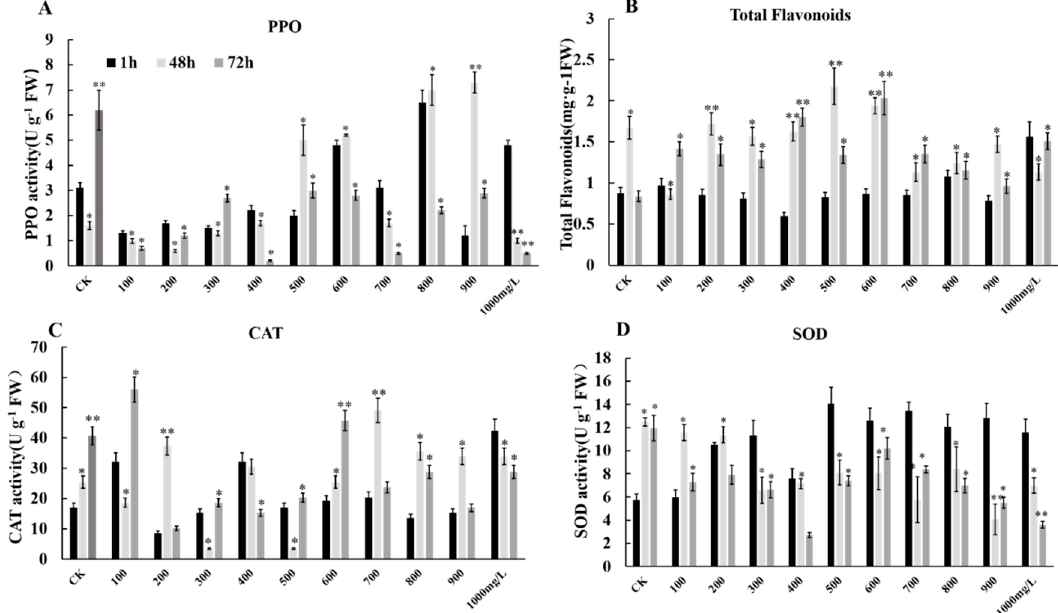
Figure 10. Effects of different concentrations of ethephon treatment on the total flavonoids and antioxidant enzymes. Different concentration of ethephon (100, 200, 300, 400, 500, 600, 700, 800, 900, and 1000 mg/L) were sprayed on the fruit surface for 24 h, and then B. cinerea was inoculated on the grape. Samples were collected at 1, 48, and 72 h after botrytis infection and measured ( A ) PPO activity, ( B ) total flavonoid content, ( C ) SOD activity and ( D ) CAT activity. Values are means ± SD of five biological replicates. * Significant differences compared with the control (water-treated fruits) sample at p < 0.05, ** Significant differences compared with the control (water-treated fruits) sample at p < 0.01 using Student’s test.